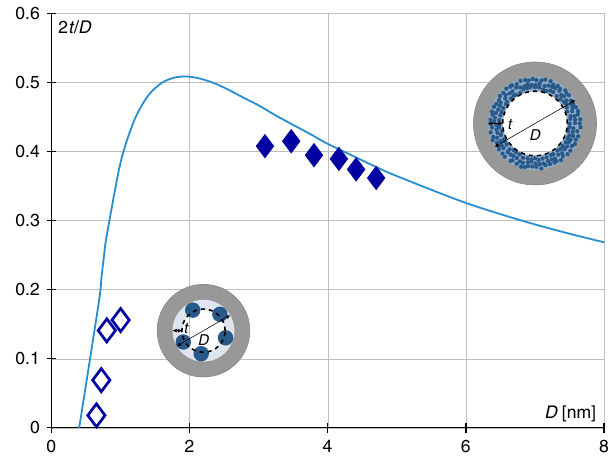
Fig. 6 Critical fl uid fi lm thickness. Ratio 2 t / D according to the pore diameter D where t is the thickness of a N 2 layer at a siliceous pore wall when the pore fi lls in. The line is a prediction from the minimization of the grand potential Ω taking into account the dependence of the Derjaguin disjoining pressure term with the thickness t . Symbols are experimental values for zeosils (open symbol, effective thickness) and for silica mesopores ( fi lled symbol, condensed fi lm thickness) 29 . The insets illustrate the ratio of the fi lm thickness t to the pore size D for both the small (left) and large (right) nanopore domains. In both cases, the blue spheres denote the adsorbed fl uid molecules while the gray and blue shaded areas indicate the adsorbed fi lm and solid matrix,